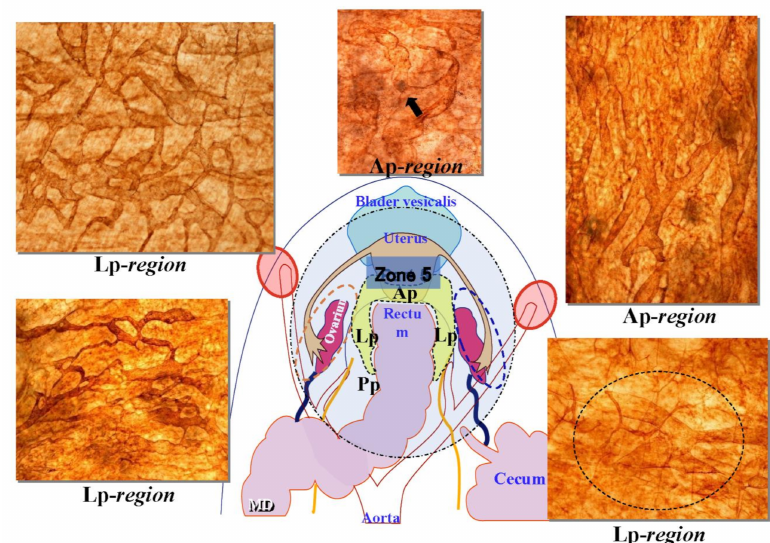
Figure 5. Submesothelial lymphatic vessels in human peritoneum (5 (cid:48) -Nase staining).